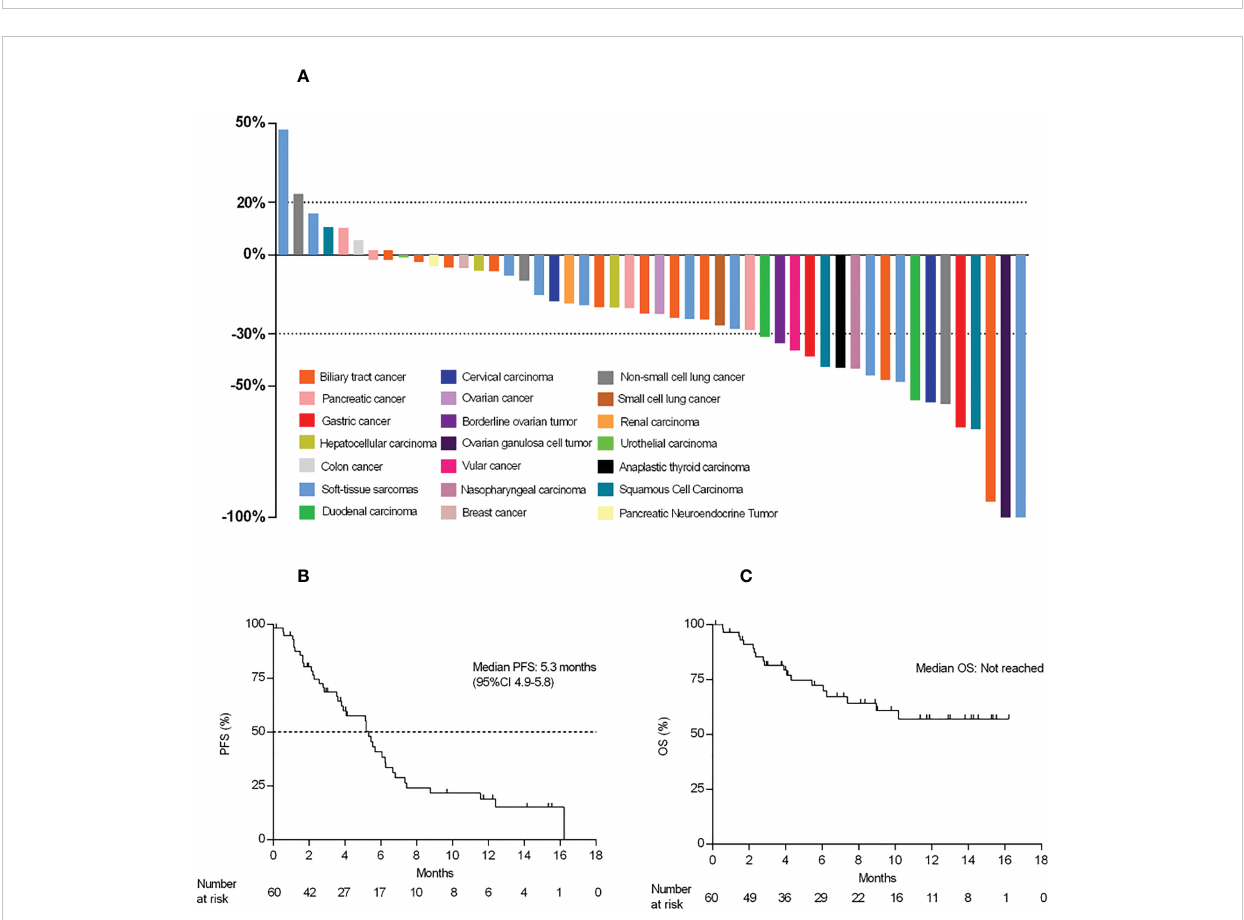
FIGURE 3 Waterfall plot and survival data. (A) Best percent change from baseline in the target lesions (n=50). (B, C) , Kaplan – Meier curve of PFS and